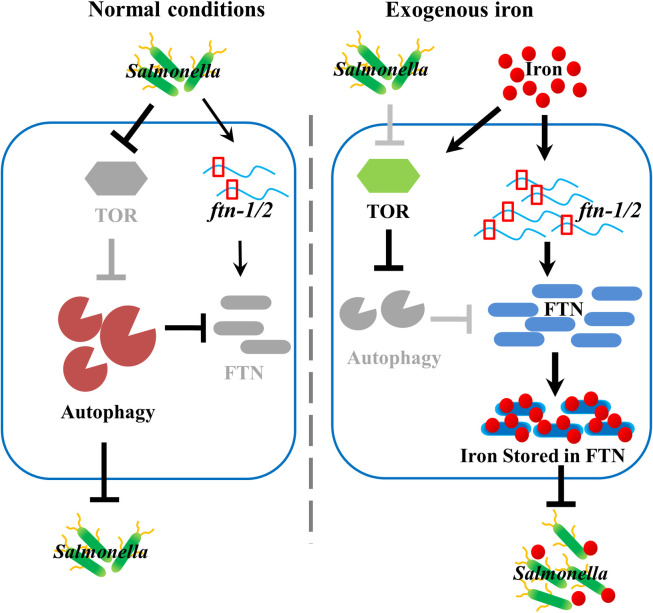
Schematic model for TOR-mediated innate immunity.As an iron sensor, Left panel: Under normal circumstances, TOR is inhibited upon Salmonella infection, leading to activation of autophagy and degradation of ferritin protein. Autophagy is responsible for inhibiting this pathogen by an unknown mechanism. Right panel: Exogenous iron activates TOR resulting in inhibition of autophagy and up-regulation of ferritin protein levels. Ferritin sequesters iron, an essential nutrient for Salmonella, to limit its proliferation.